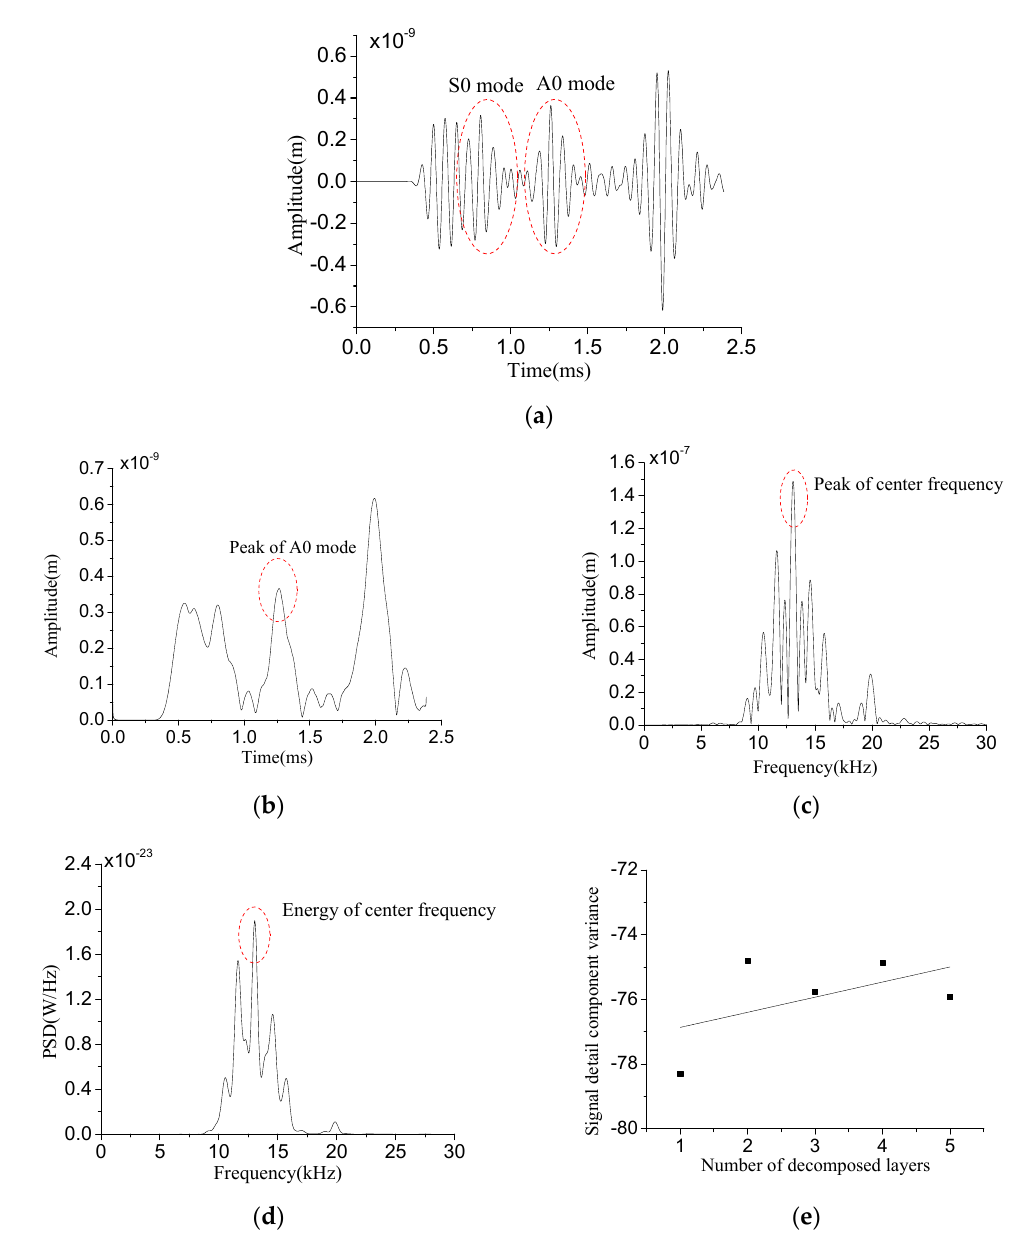
Figure 7. Lamb wave feature extraction of surface crack. ( a ) Received Lamb wave signal; ( b ) Hilbert wave packet of Lamb wave signal; ( c ) fast Fourier transform (FFT) amplitude of Lamb wave signal; ( d ) power spectral density (PSD) energy of Lamb wave signal; ( e ) Fitting straight line of Lamb wave wavelet fractal.